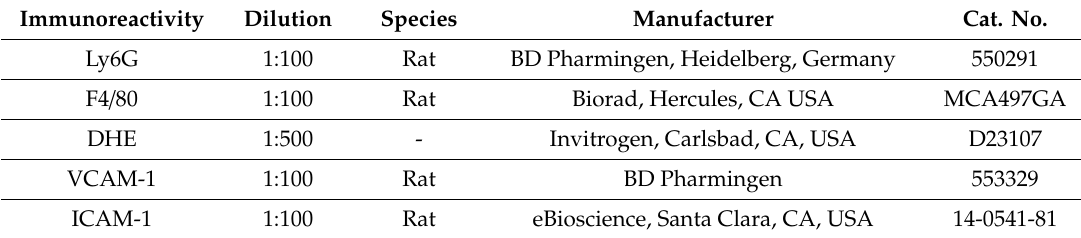
Table 1. Primary antibodies for immunofluorescence